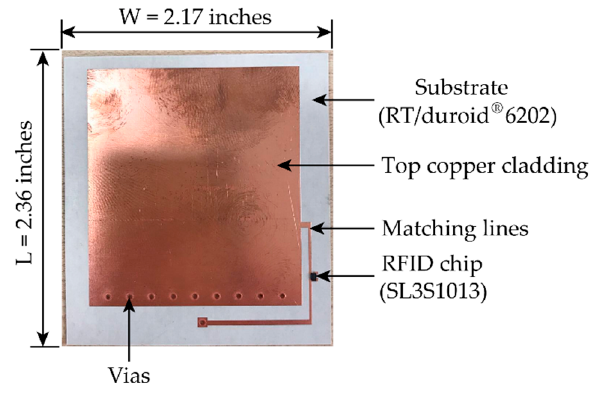
Figure 1. A prototype of the passive patch antenna sensor.